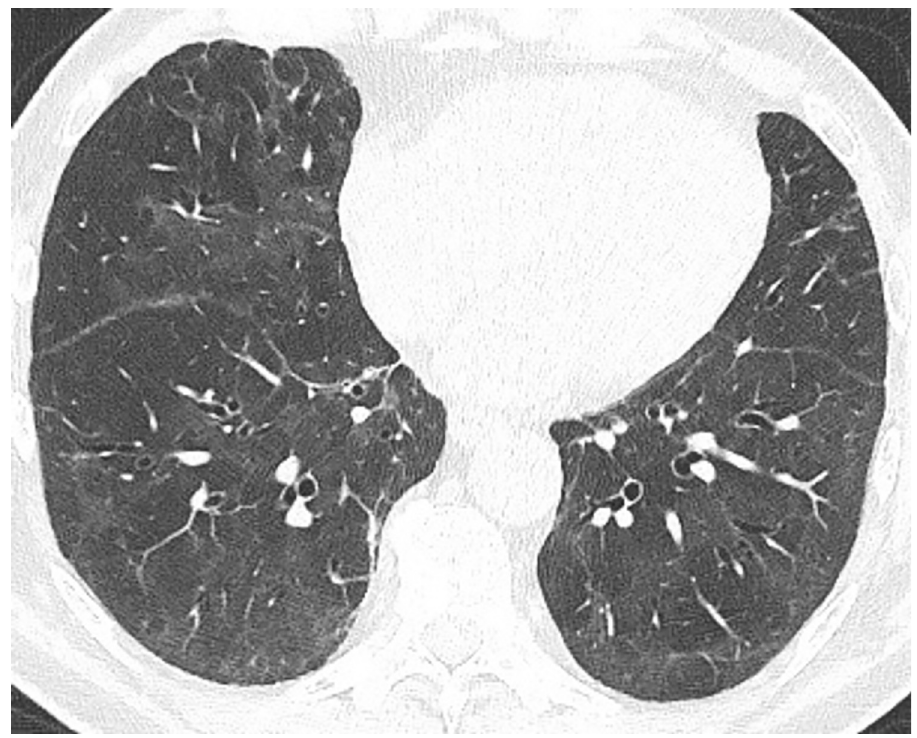
Fig 1. Computed tomography scan 3 months following SARS-CoV2 infection. Bilateral ground-glass opacities and mild peripheral reticular pattern.